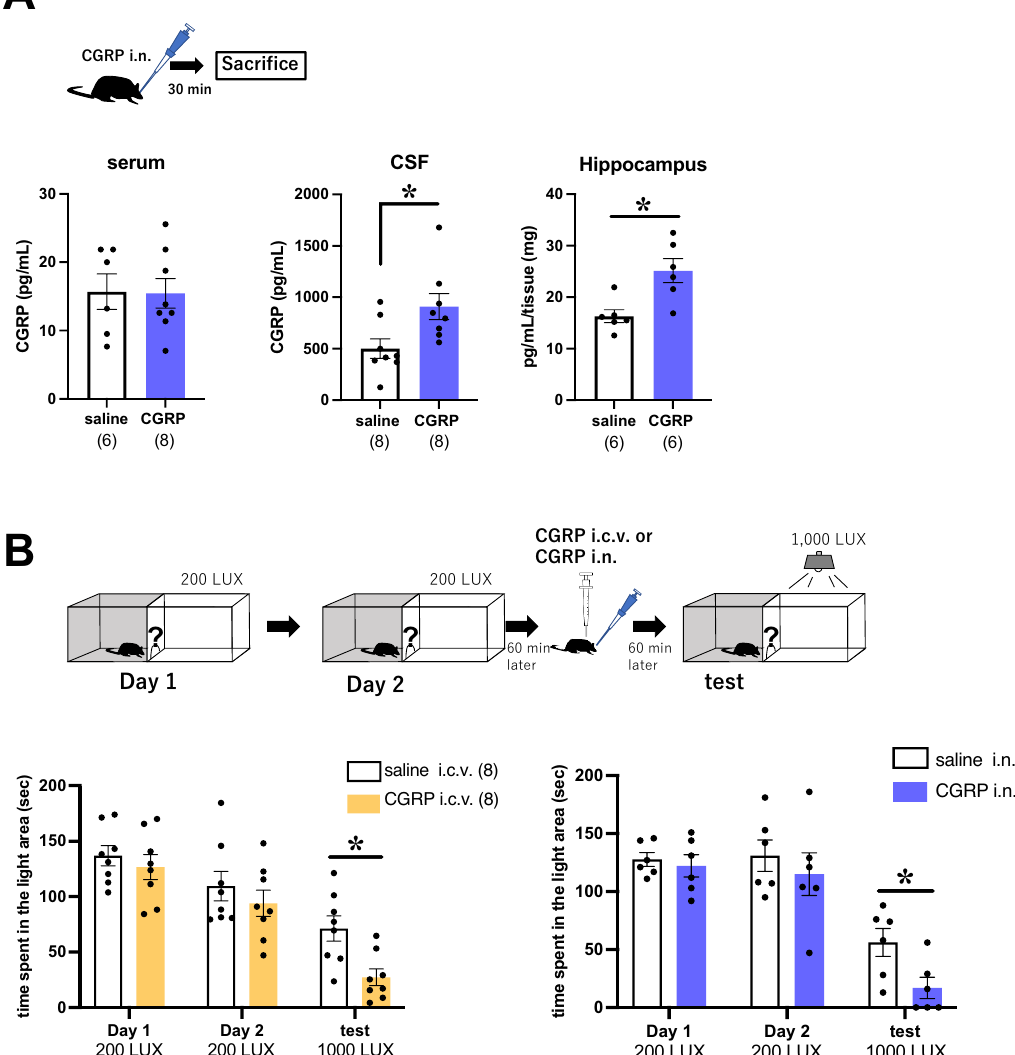
Figure 1. Changes in CGRP distribution and photophobic behavior after intranasal administration of CGRP. ( A ) CGRP expression was assessed in the serum, cerebrospinal fluid (CSF) and hippocampus using ELISA 30 min after CGRP application. ( B ) Photophobic behavioral assay results in saline and CGRP-treated mice. Each bar indicates the mean ± S.E.M. * p < 0.05, Welch’s t test. Numbers in parentheses indicate the number of animals in each